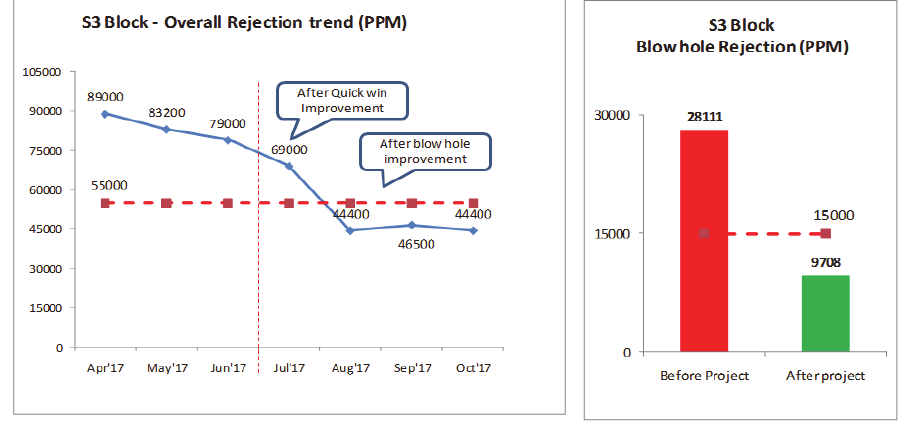
Fig. 15. Results of Overall Rejection